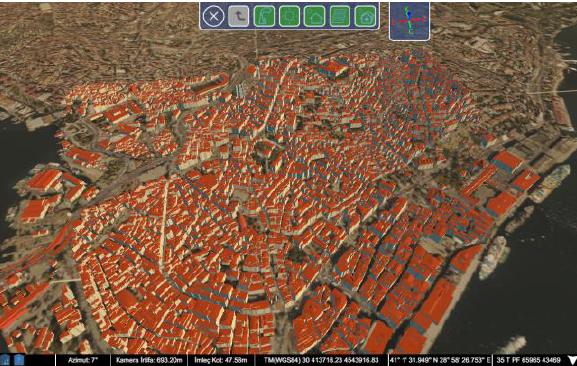
Figure 9. Default GUI view of Istanbul Solar Estimation.